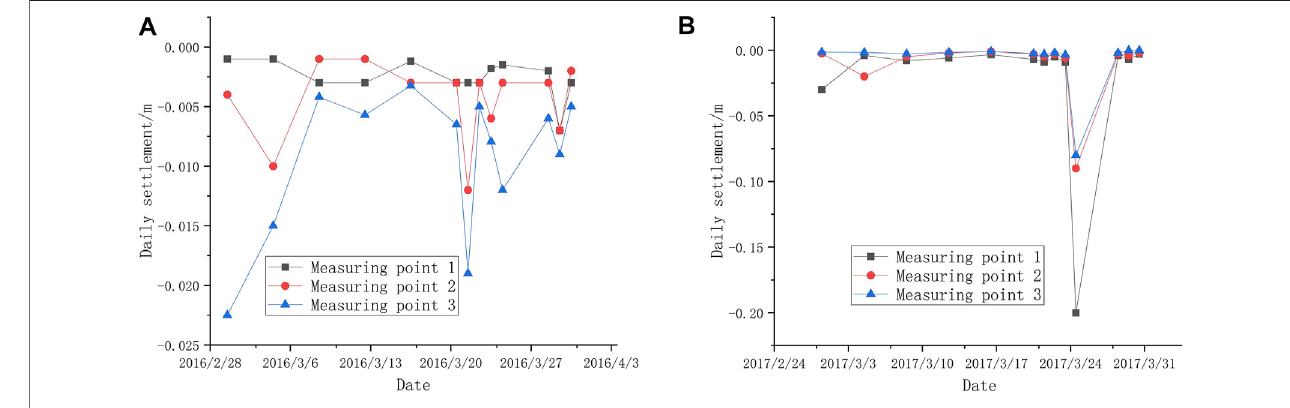
FIGURE 7 | Surface settlement curve.